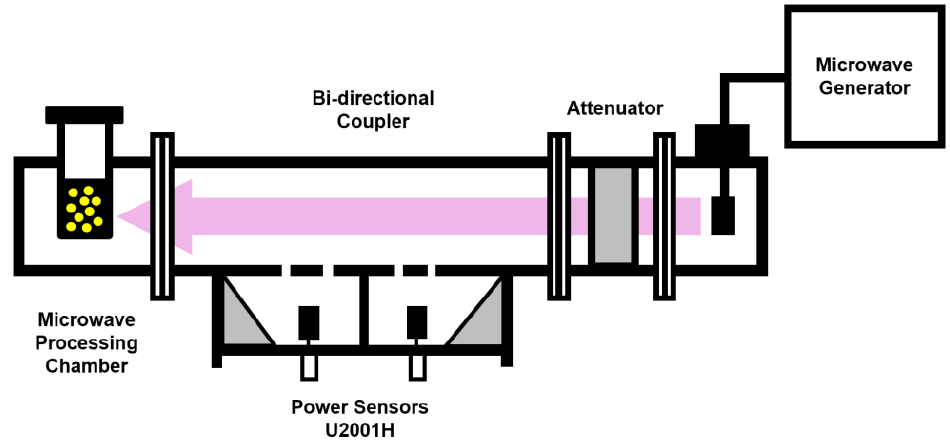
Figure 2. Schematic diagram of the laboratory stand applied for studying the effect of microwave heating with iron oxide nanoparticles on heavy oil composition changes. Table 1. SARA and elemental analysis of oil samples in the absence and presence of iron oxide nanoparticles under microwave